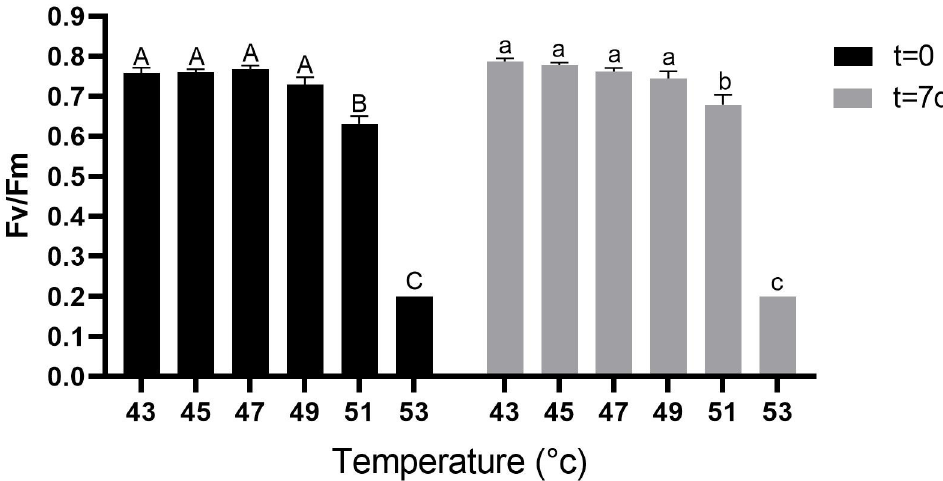
Figure 3. Quantum yield of photosystem II (Fv/Fm) calculated from chlorophyll a fluorescence recorded after dark adaptation. Measurements were taken right after climate chamber incubation and before exposure to sunlight (t = 0), and pre-dawn after seven days in the net house (t = 7 d). Each treatment was replicated four times with four different plants for each replicate. Values are means ± SE of at least four different leaves on each of the 16 plants ( n = 16). Columns marked with different letters differ significantly (Tukey-HSD, p < 0.05); uppercase letters for t = 0 and lowercase letters for t = 7 d .